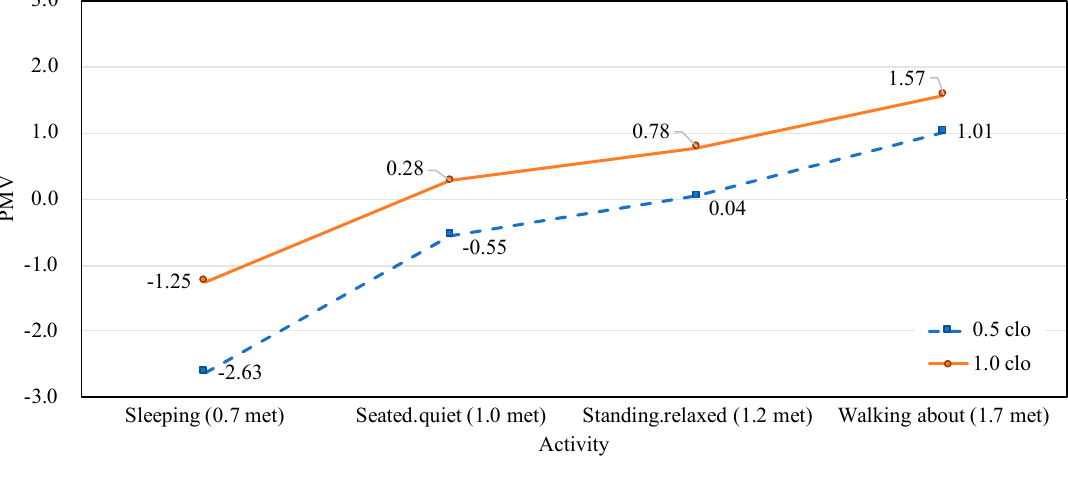
Figure 1. E ff ects of the metabolic rate on the thermal Figure 1. Effects of the metabolic rate on the thermal comfort.